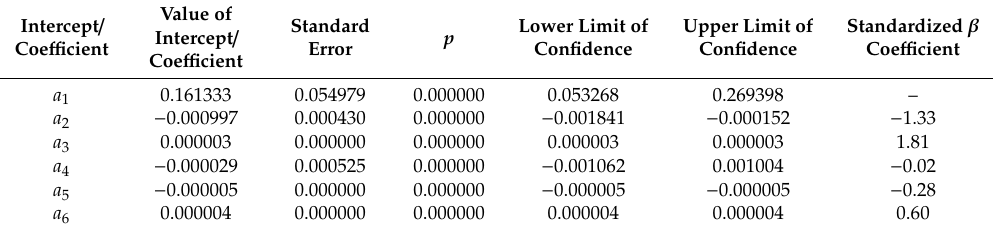
Table 6. Statistical evaluation of ash content ( AC ) model of torrefied pruned